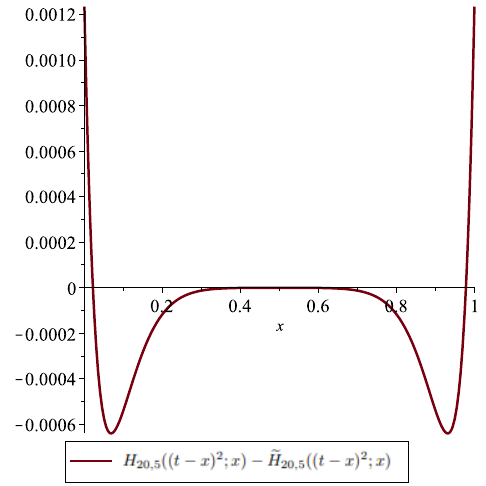
Figure 2. Difference in the central moments for n = 20, ρ =